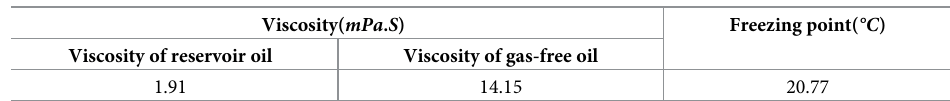
Table 1. Physical property of